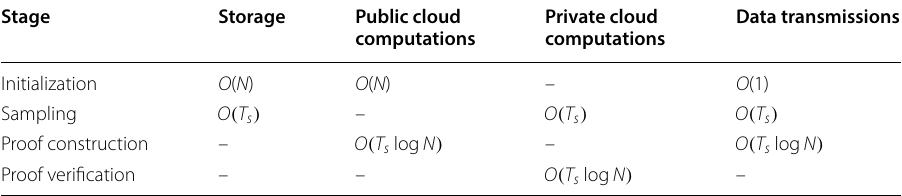
Table 2 Time and space complexity analysis for the proposed approach